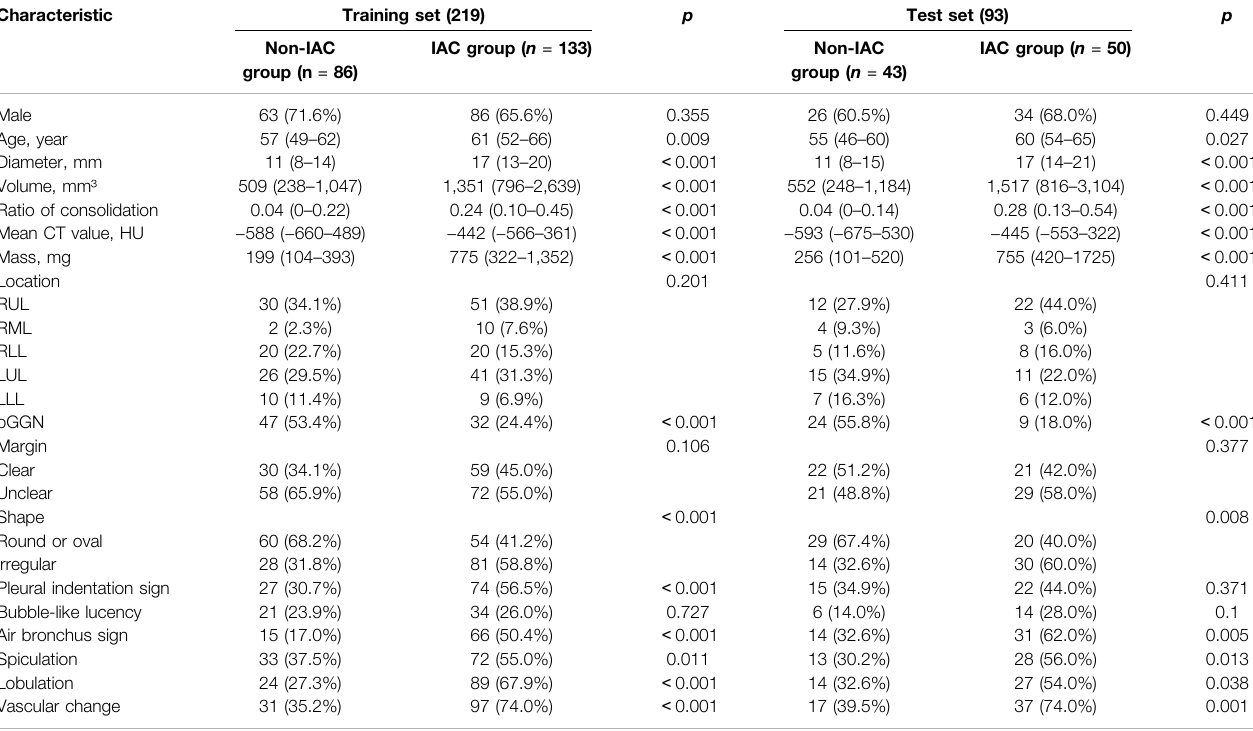
TABLE 3 | Univariate analysis of clinical and imaging features in the training and test sets. Characteristic